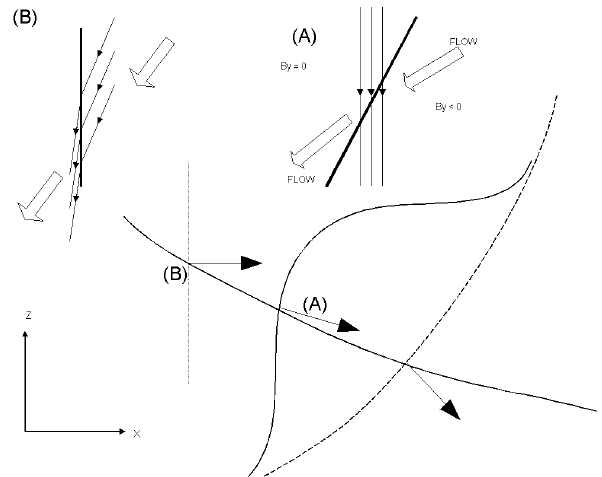
Fig. 8. A sketch of the cusp encounter at 20:00UT on 13 February 2001. In the lower part, we show a conjectured geometry: note that the sketches are not to scale. The solid line running from lower right to upper left is the spacecraft trajectory. The outer dashed line is a sketch of the nominal magnetopause position, with the relevant normal. The next (solid) line is a possible magnetopause geometry that gives rise to the measured normal (shown by the arrow and labelled A). The inner boundary is shown by the dotted line with the relevant normal. The upper right and left parts of the sketch show the magnetic field and plasma configuration at the outer and inner boundaries,